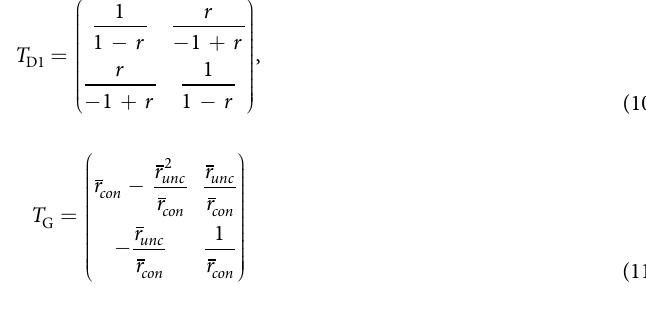
8 Scientific REPORts | 7: 9103 | DOI:10.1038/s41598-017-09561-y